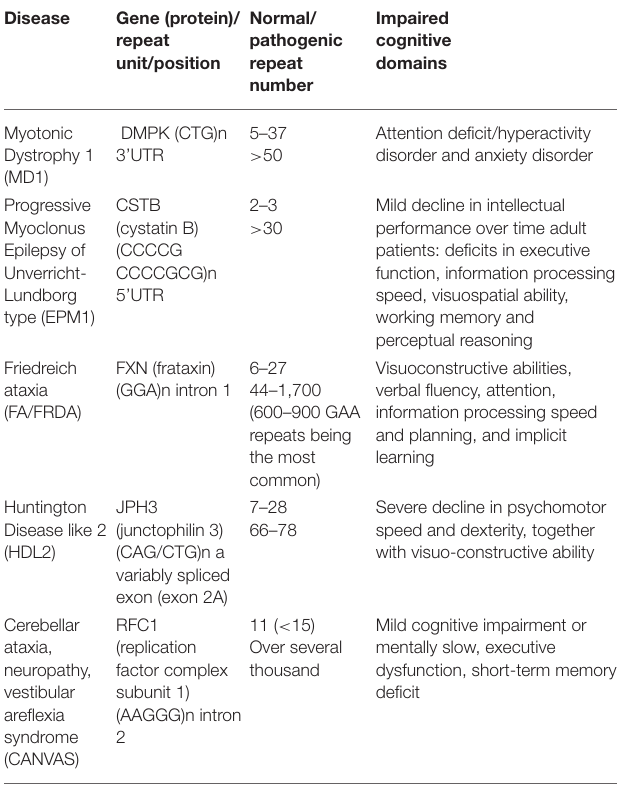
TABLE 2 | The pathogenic gene, repeat numbers, and impaired cognitive domains in other repeat expansion diseases (REDs) with relatively rare data.